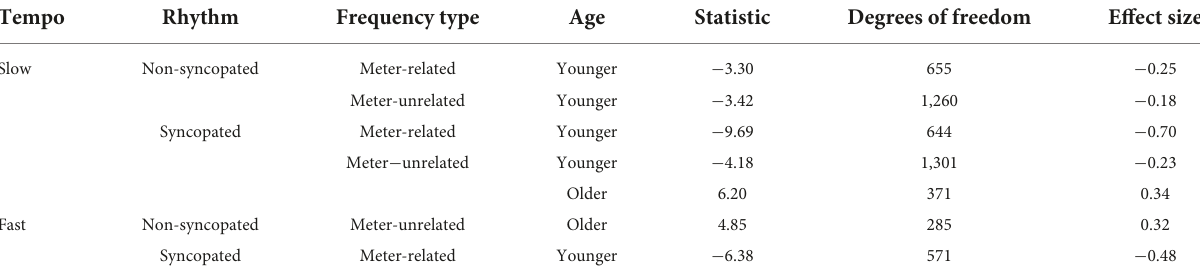
TABLE 2 Summary of significant simple musicianship effects for frequency type analysis, including tempo, rhythm, frequency type, and age.